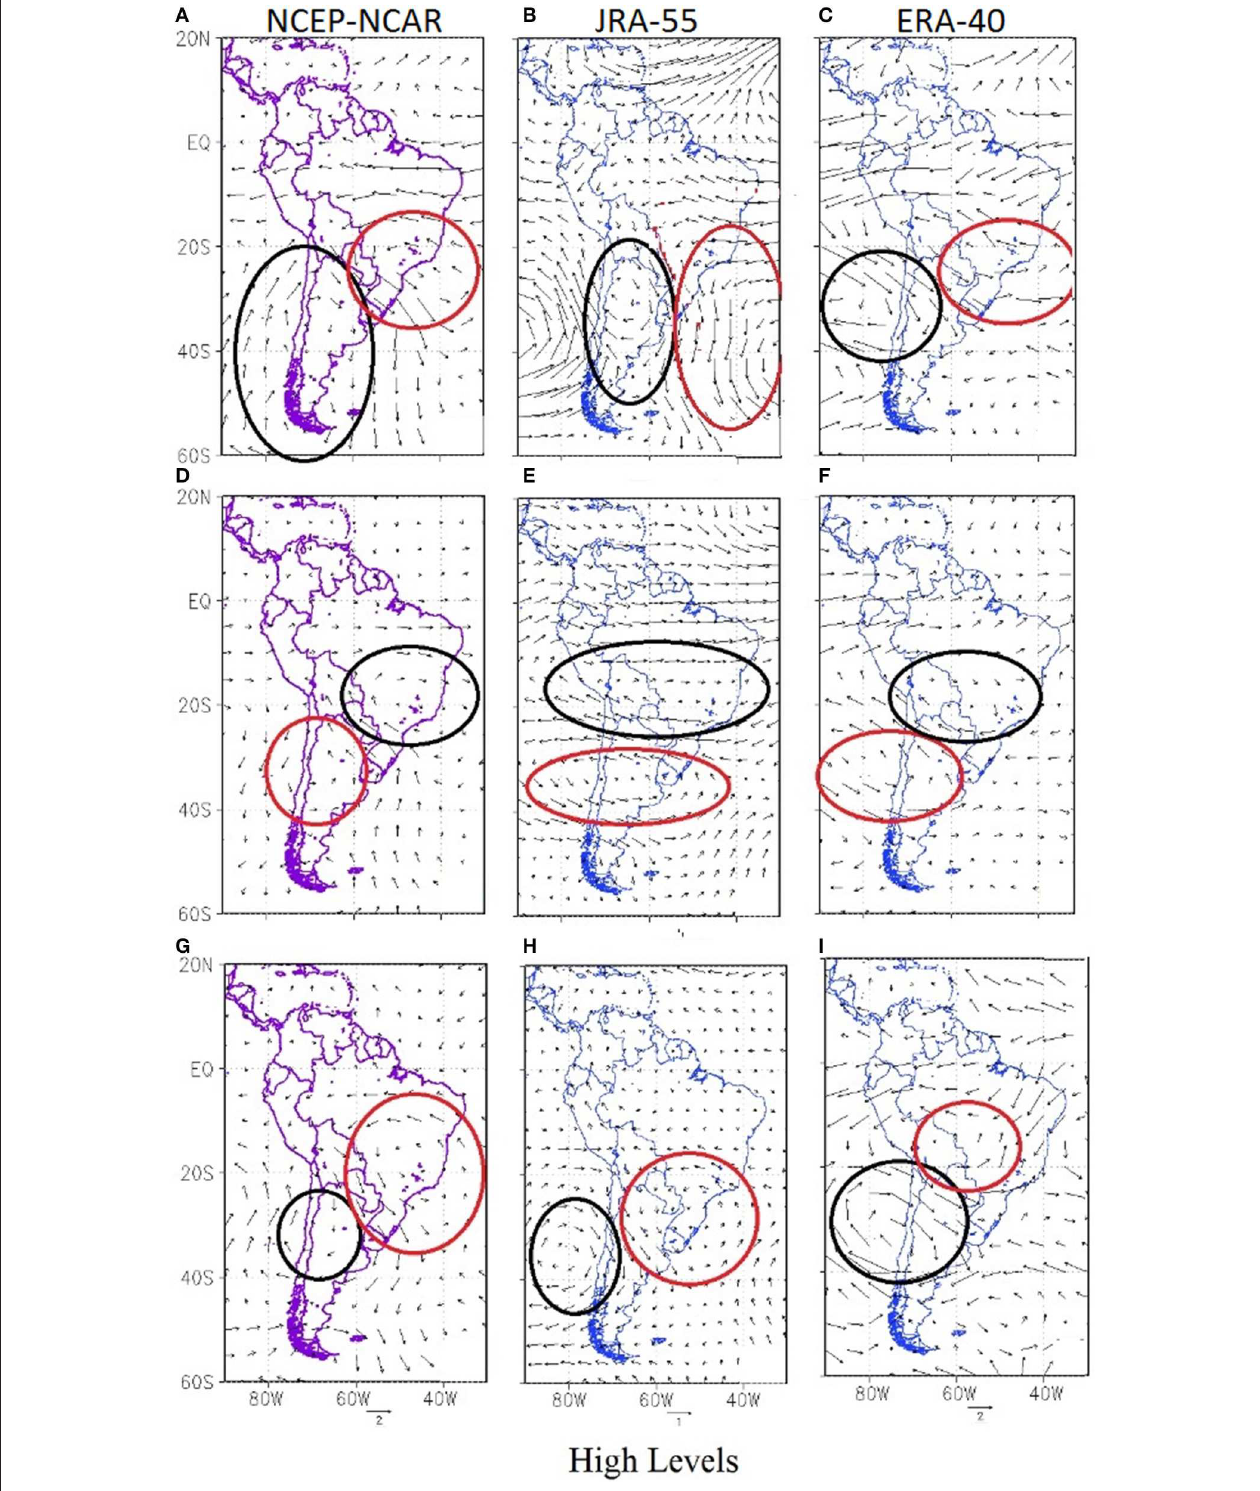
FIGURE 3 | High levels (500–200 hPa) mean wind vector anomaly (m s − 1 ) for the (A–C) 1st (1970–1976), (D–F) 2nd (1977–1996), and (G–I) 3rd (1997–2001) subperiods, for NCEP-NCAR (A,D,G) , JRA-55 (B,E,H) , and ERA-40 (C,F,I) reanalysis. Black (red) circles represent regions with a predominance of cyclonic (anticyclonic) wind